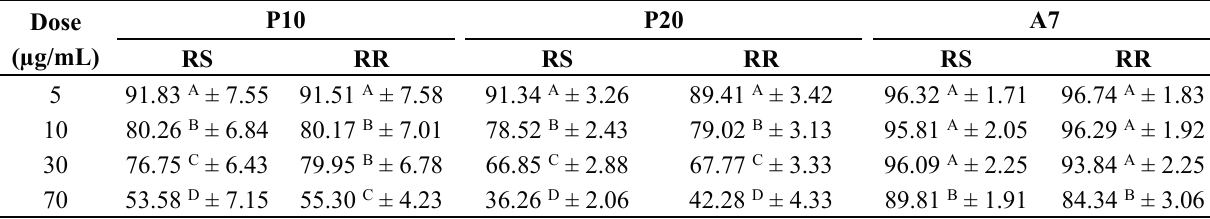
Table 1. Modulation of MTT metabolism by RS or RR extracts in human omental pre-adipocytes. Cells were treated with different doses of extracts. P10 differentiating pre-adipocytes treated for 10 days; P20 differentiating pre-adipocytes treated for 20 days; A7, mature adipocytes treated for 7 days. Data are expressed as percentage of control cells (untreated) and presented as means ± standard deviation (SD). Different superscript capital letters indicate significant differences ( p < 0.001) within treatments at different concentrations.